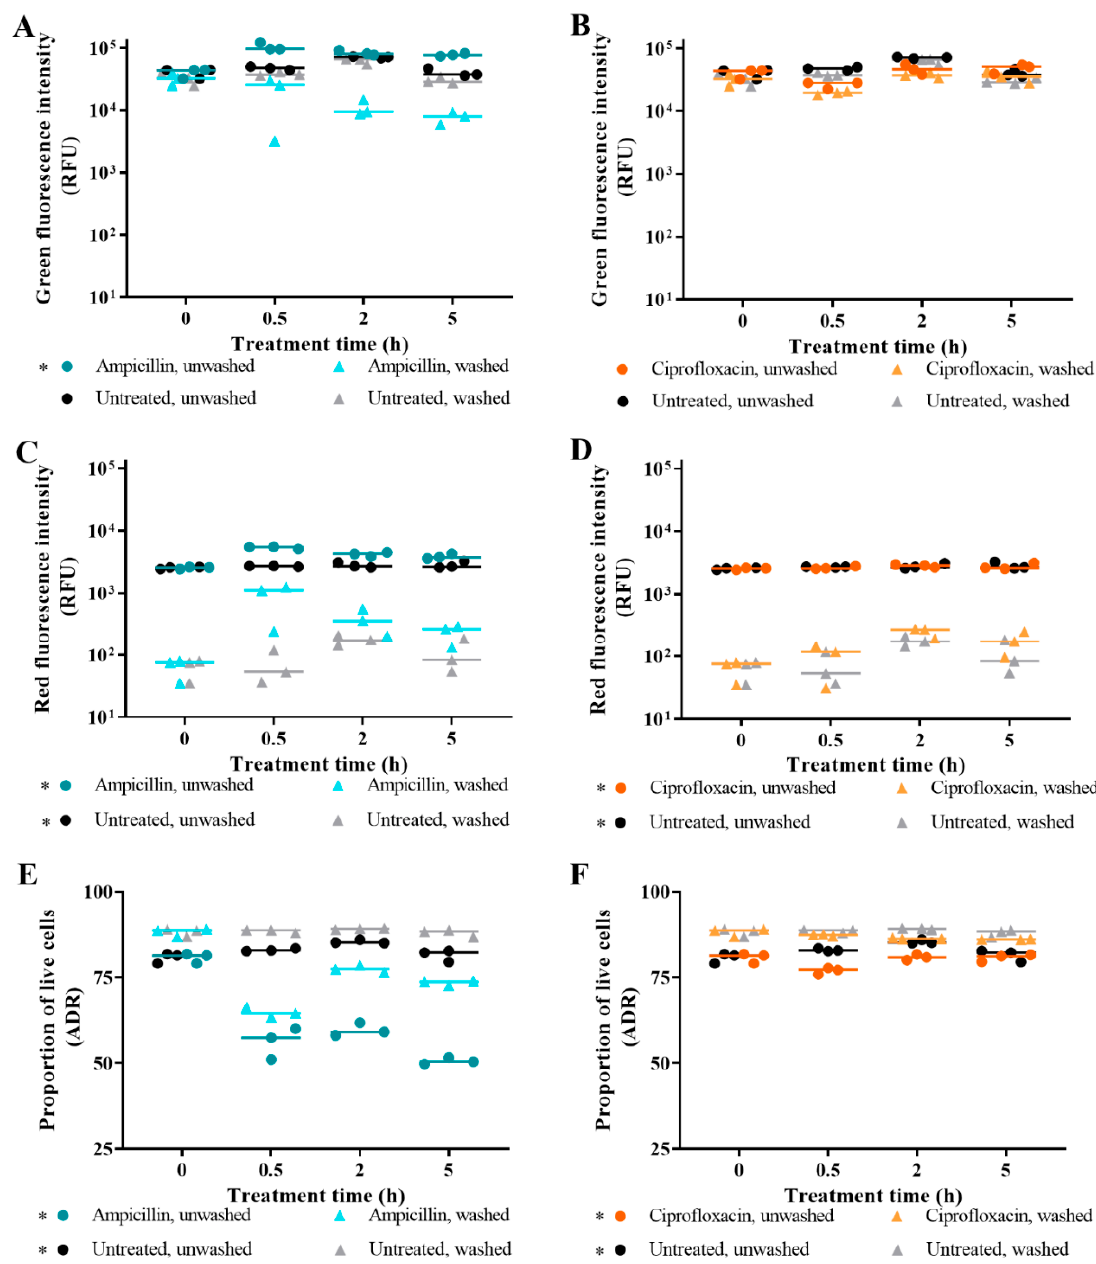
Figure 3. The impact of post-staining washing of antibiotic-challenged E. coli . The effect of washing aliquots after staining is presented for SYTO 9-stained cells ( A , B ); PI-stained cells ( C , D ); and SYTO 9- and PI-stained cells ( E , F ). E. coli was challenged with ampicillin (teal/cyan), ciprofloxacin (orange), or nothing (untreated; black/grey), and samples were taken at 0 h (pre-treatment), 0.5 h, 2 h, and 5 h. Following staining of duplicate aliquots with SYTO 9 and/or PI, and one aliquot was left unwashed and the other aliquot was washed in fresh MM. Fluorescence intensities were obtained from integrating at 505–515 nm for green emissions and 600–610 nm for red emissions. The adjusted dye ratio (ADR) was calculated using the green and red emissions from SYTO 9- and PI-stained samples to indicate the proportion of live cells in the aliquot. Each dot represents a biological replicate, and the median is shown by the line. Statistical significance between washed and unwashed samples is represented by * (two-way RM ANOVA, p value: <0.05, Tukey multiple comparisons